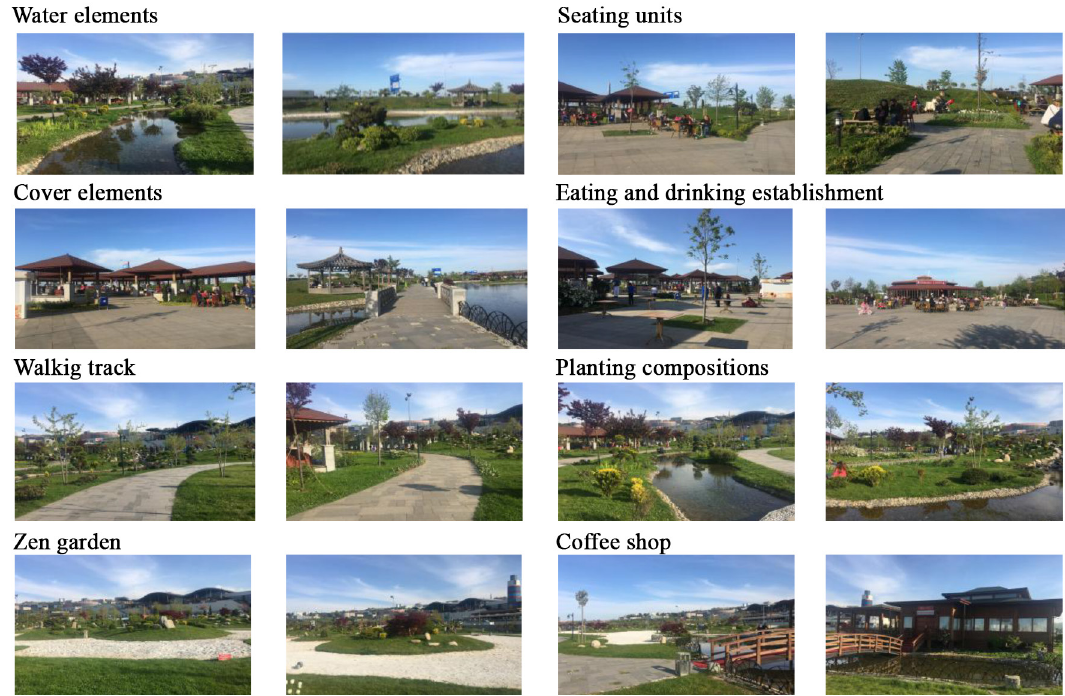
Figure 3. EYOF Memory Park activity areas and qualities of the space